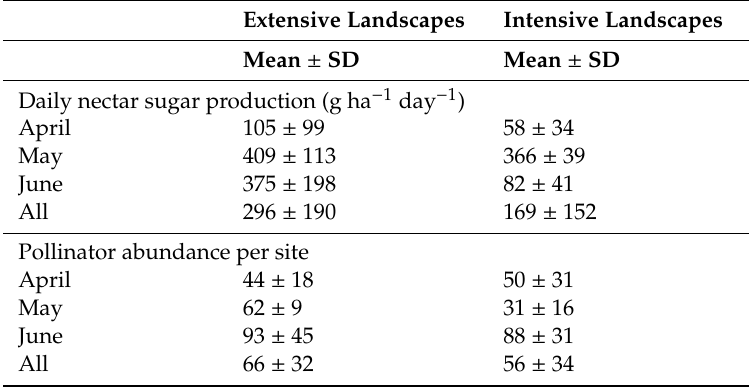
Table 3. Mean daily nectar sugar production at the landscape scale and mean pollinators abundance per site between extensive and intensive